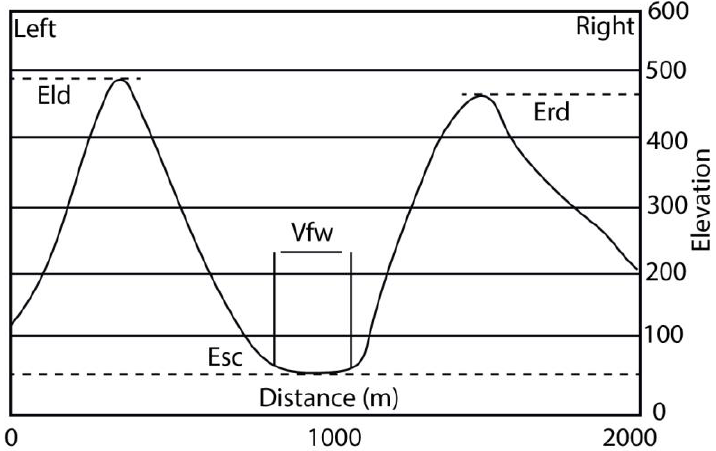
Figure 5. Scheme of calculation valley floor width to valley height ratio index, V f .